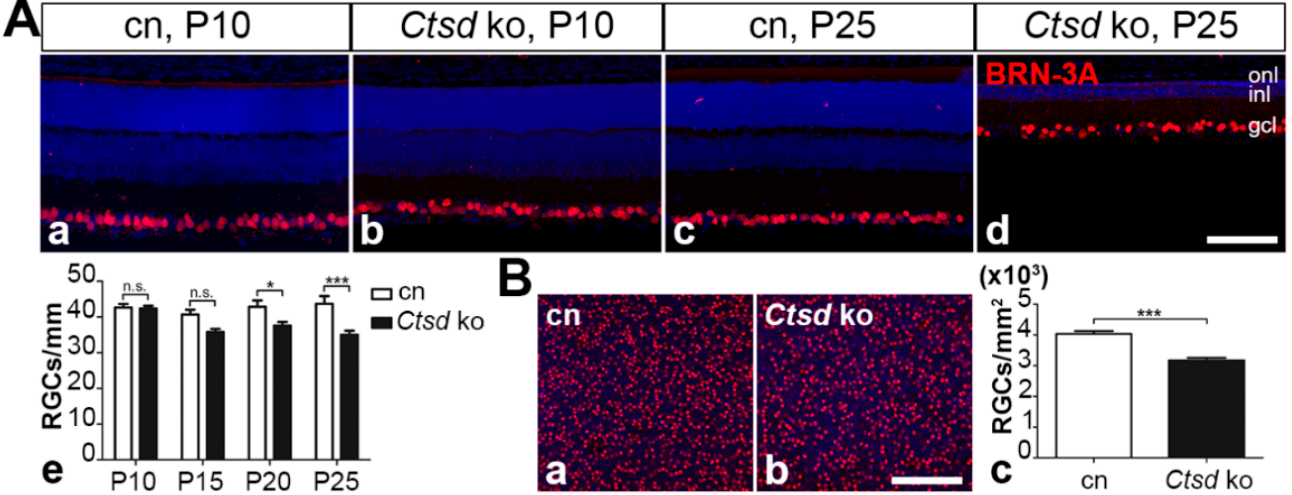
Figure 8. Degeneration of retinal ganglion cells. ( A ) Retina sections from Ctsd ko mice contained normal numbers of BRN- 3A-positive ganglion cells at P10 ( Ab ) but reduced ganglion cell numbers at P25 ( Ad ) when compared with age-matched control retinas ( Aa , Ac , respectively). Quantitative analyses of retina sections confirmed a significantly decreased RGC density in Ctsd ko retinas (filled bars in Ae ) starting from P20 when compared with age-matched control retinas (open bars in Ae ). n.s., not significant; *, p < 0.05; ***, p < 0.001, two-way ANOVA. ( B ) Analyses of retinal flatmounts from P25 Ctsd ko ( Bb ) and control mice ( Ba ) confirmed a significant loss of ganglion cells in the mutant at this age ( Bc ). ***, p < 0.001, Student’s t -test. Each bar in ( A , B ) represents the mean value ( ± SEM) of at least 6 animals. BRN-3A, brain-specific homeobox/POU domain protein 3A; cn, control; gcl, ganglion cell layer; inl, inner nuclear layer; ko, knock-out; onl, outer nuclear layer; P, postnatal day. Scale bars: 100 µm.